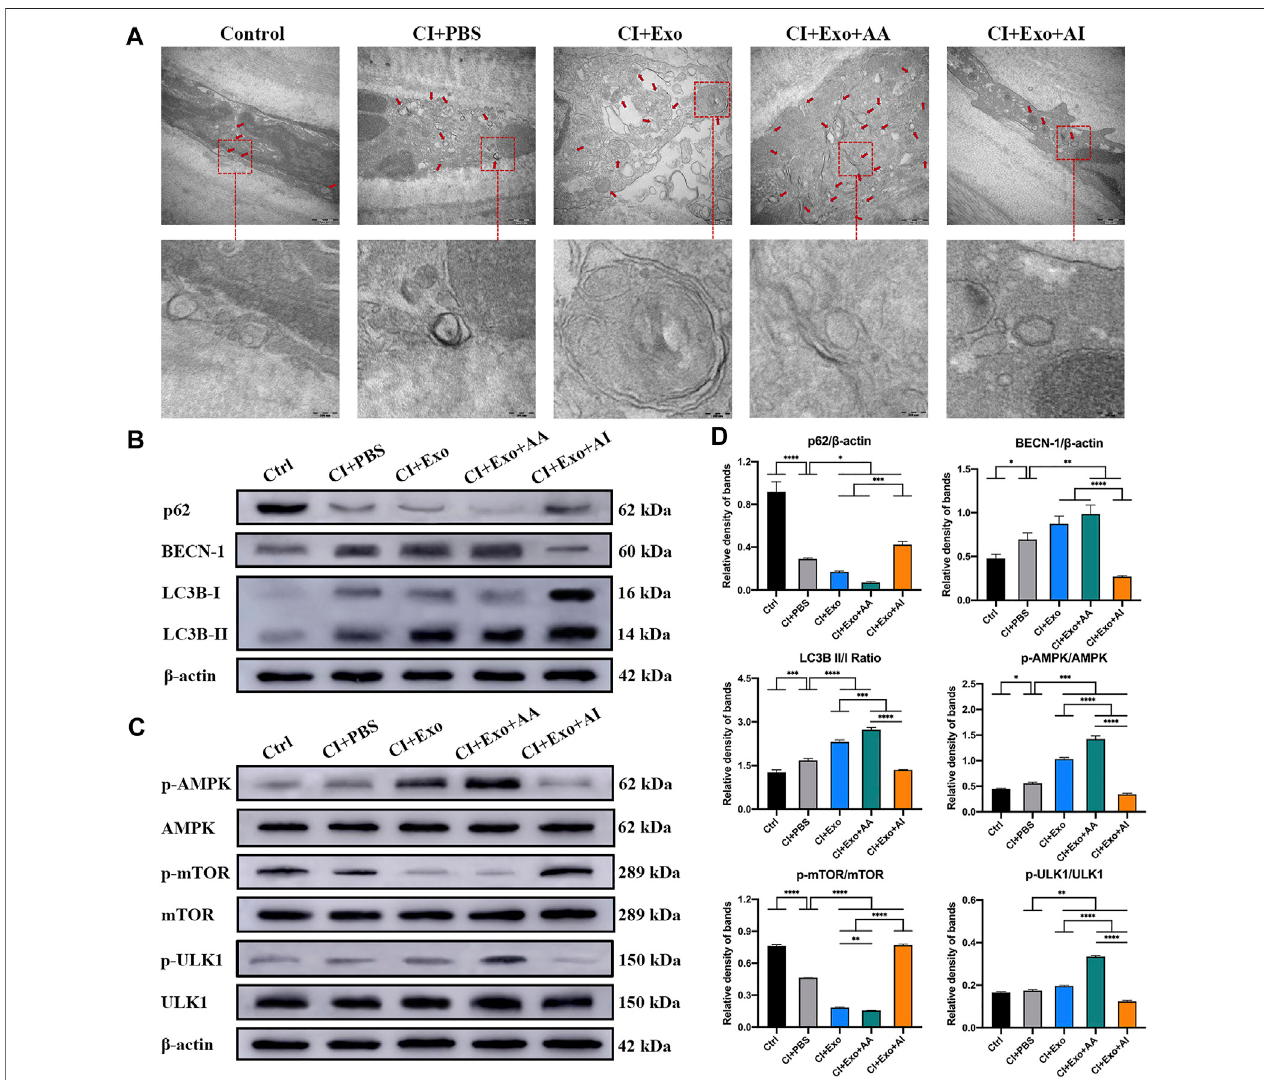
FIGURE 7 | Effect of combination treatment with hucMSC-Exos and autophagy regulators on autophagy levels in CI mouse corneas. (A) Representative high- magni fi cation TEM images showing the autophagosome counts in the groups. Scale bar: 500 and 100 nm. (B) Western blotting showing autophagy markers p62, Beclin-1, and LC3B. (C) Western blotting showing the AMPK-mTOR-ULK1 autophagy fl ux pathway proteins pAMPK, AMPK, pULK1, ULK1, pmTOR and mTOR. (D) Relative band densities ofp62, Beclin-1, LC3B II/I, pAMPK/AMPK, pULK1/ULK1, and pmTOR/mTOR, quanti fi ed in bar graphs. Data are shown as mean ± SD. *p < 0.05,**p < 0.01,***p < 0.001,****p < 0.0001.(Control:normalcorneastreatedwithPBS,CI+PBS:injuredcorneastreatedwithPBS,CI+Exo:injuredcorneastreated with1×10 6 / μ LhucMSC-Exos,CI+Exo+AA:injuredcorneastreatedwith1×10 6 / μ LhucMSC-Exosand10 μ MRapamycin,CI+Exo+AI:injuredcorneastreatedwith 1 × 10 6 / μ l hucMSC-Exos and 50 μ M Compound